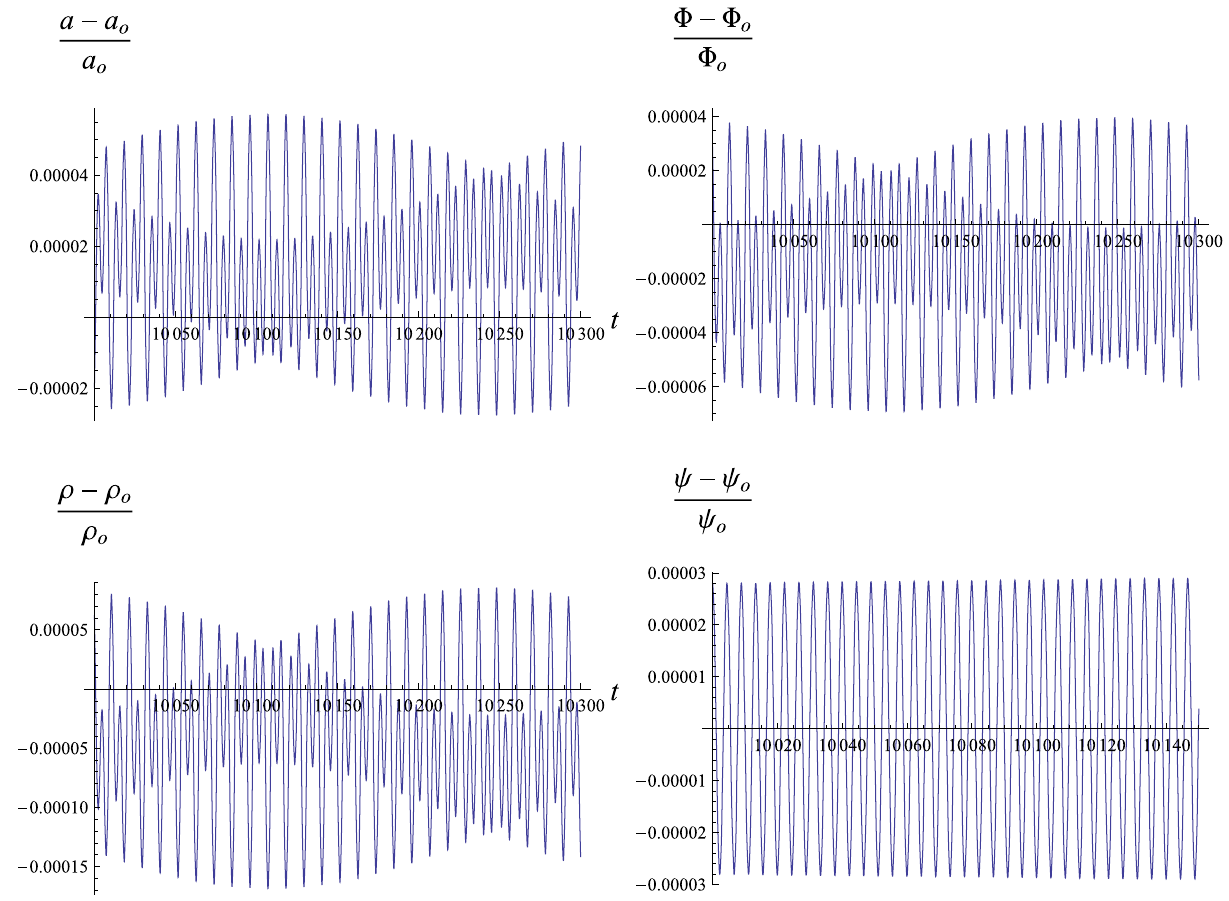
Fig. 4 Behavior of the scale factor a , the JBD field φ , the perfect fluid density ρ and the inflaton field ψ as a function of cosmological